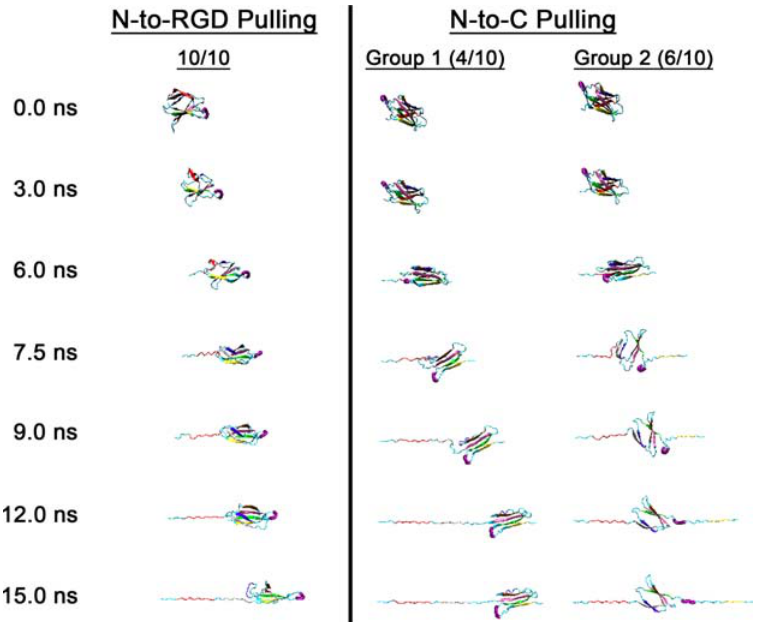
Figure 5. Snapshots of Early Events in the Unfolding Process (time # 15 ns). Unfolded structures show b -strand coloring corresponding to those defined in Figure 1A. The RGD loop is highlighted as a purple tube. The structures are oriented such that the N-terminal ends are on the left so that pulling of 10FNIII occurs towards the right. Unfolding as a function of time (labeled at left) is shown vertically for both N-to-RGD and N-to-C axes.